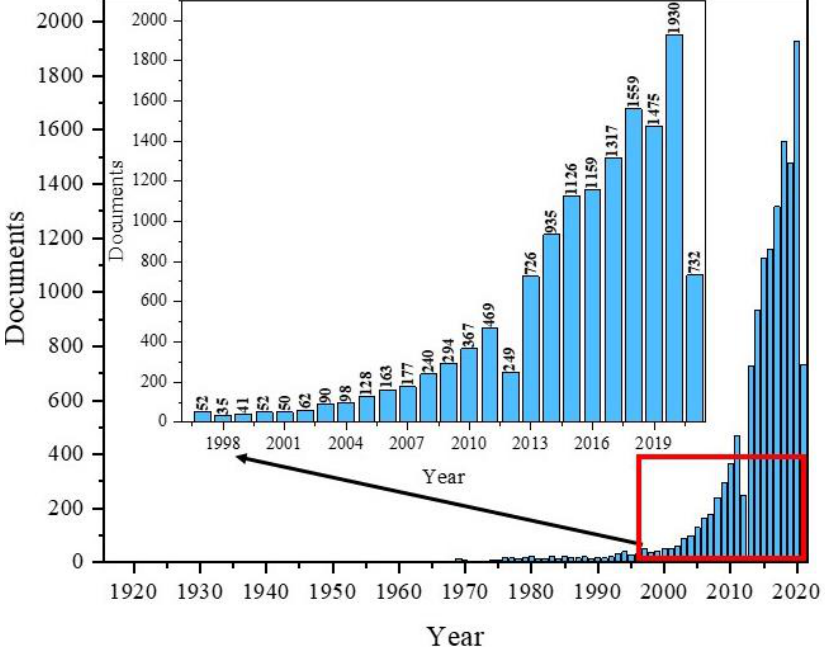
Figure 1. Scheme of the number of publications with “Fe 3 O 4 ” in title based on the year of publication using the Scopus base.